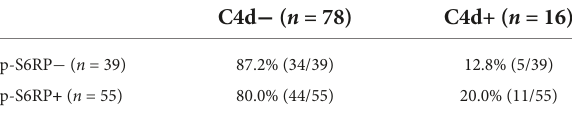
TABLE 6 Correlation table between p-S6RP and C4d staining.